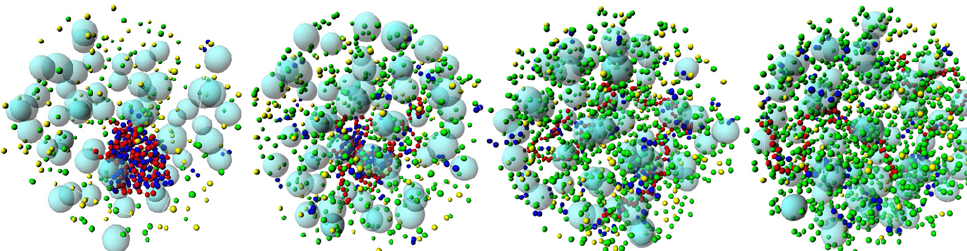
Figure 8. Representative snapshots showing the dissociation of the DNA (red)–H-NS (dark blue) complex upon the increase in the surface charge density of the crowding particles (light blue). The counterions of the model H-NS are represented in yellow and those of DNA and crowders in green. ε pp = 1, Φ crow = 0.06 and σ crow is 0, − 0.40, − 0.80 and − 1.20 e /nm 2 , from the left to the right-hand